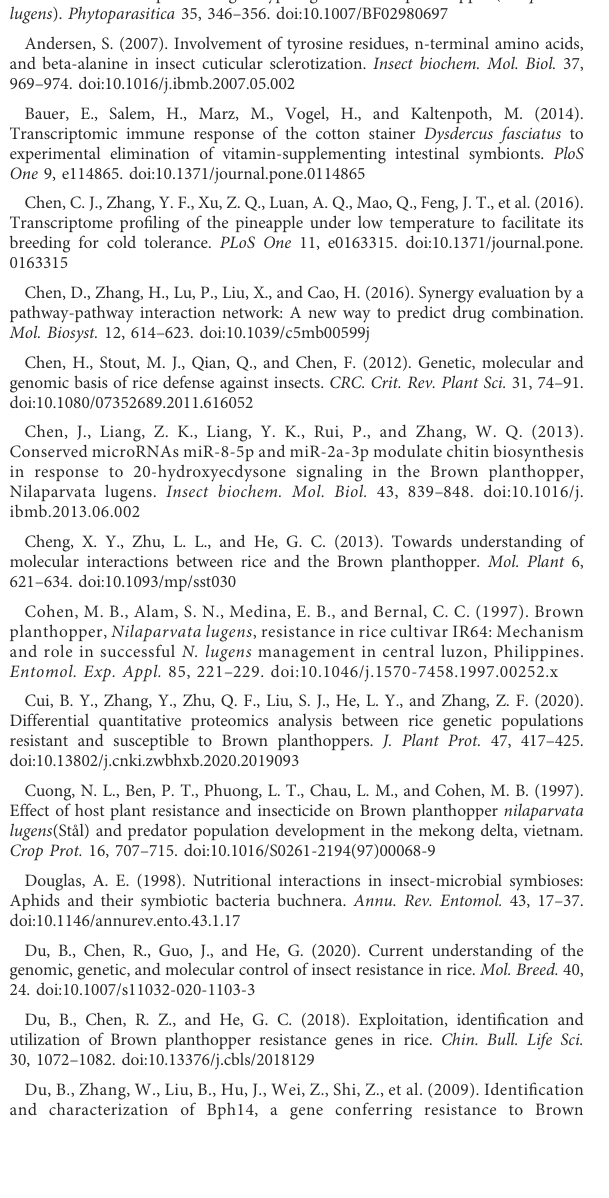
SUPPLEMENTARY FIGURE S1 Orthogonal partial least squares-discrimination analysis (OPLS- DA) plots of metabolite composition of samples from BPH reared on RH and TN1 varieties. Each symbol represents a sample; Different symbol shapes denote different groups. The circle line indicates the 95% con fi dence interval (Hotelling ’ s T-squared ellipse). SUPPLEMENTARY FIGURE S2 Pathways of Galactose metabolism, (A) Ascorbate and aldarate metabolism (B) , Pentose and glucuronate interconversions (C) , Starch and sucrose metabolism (D) and Amino sugar and nucleotide sugar metabolism (E) affected by different rice varieties. Red indicates that the gene/compound is upregulated, blue indicates that the gene/ compound is